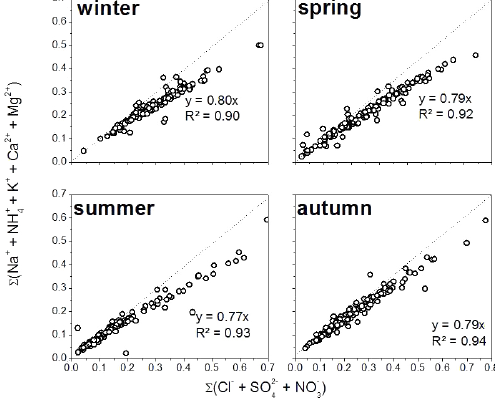
Figure 4. Charge balance of ions (µeqm − 3 ) on a seasonal